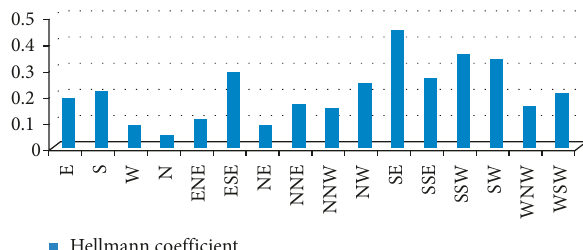
Figure 5: Change of the Hellmann coefficient as per wind